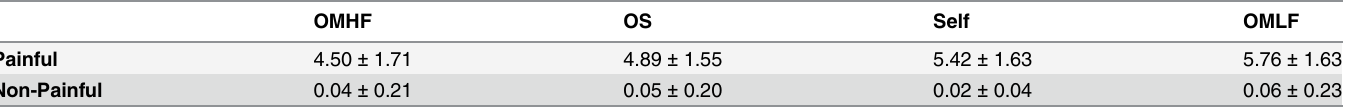
Table 1. Pain ratings (Mean values ± SD) as a function of stimuli (painful vs. non-painful) and perspective (other-negative familiar, other-unknown, self, other-positive